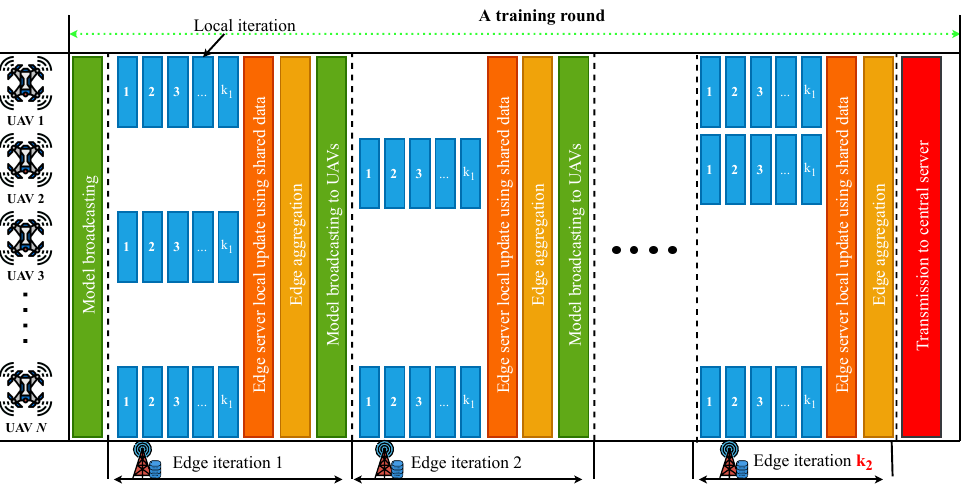
Figure 2. Overall process of the